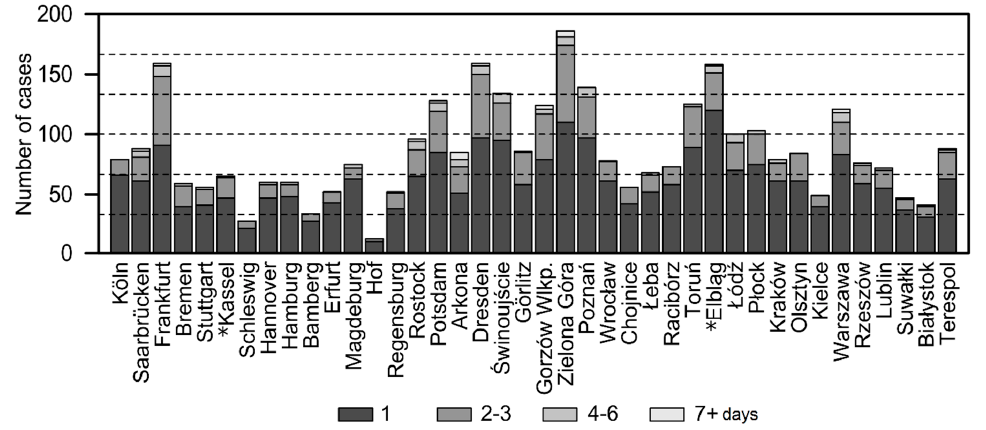
Figure 4. Number of hot nights by duration in the summers (June–August) 1966–2015 (* stations with a shorter measurement series 1966–2013).